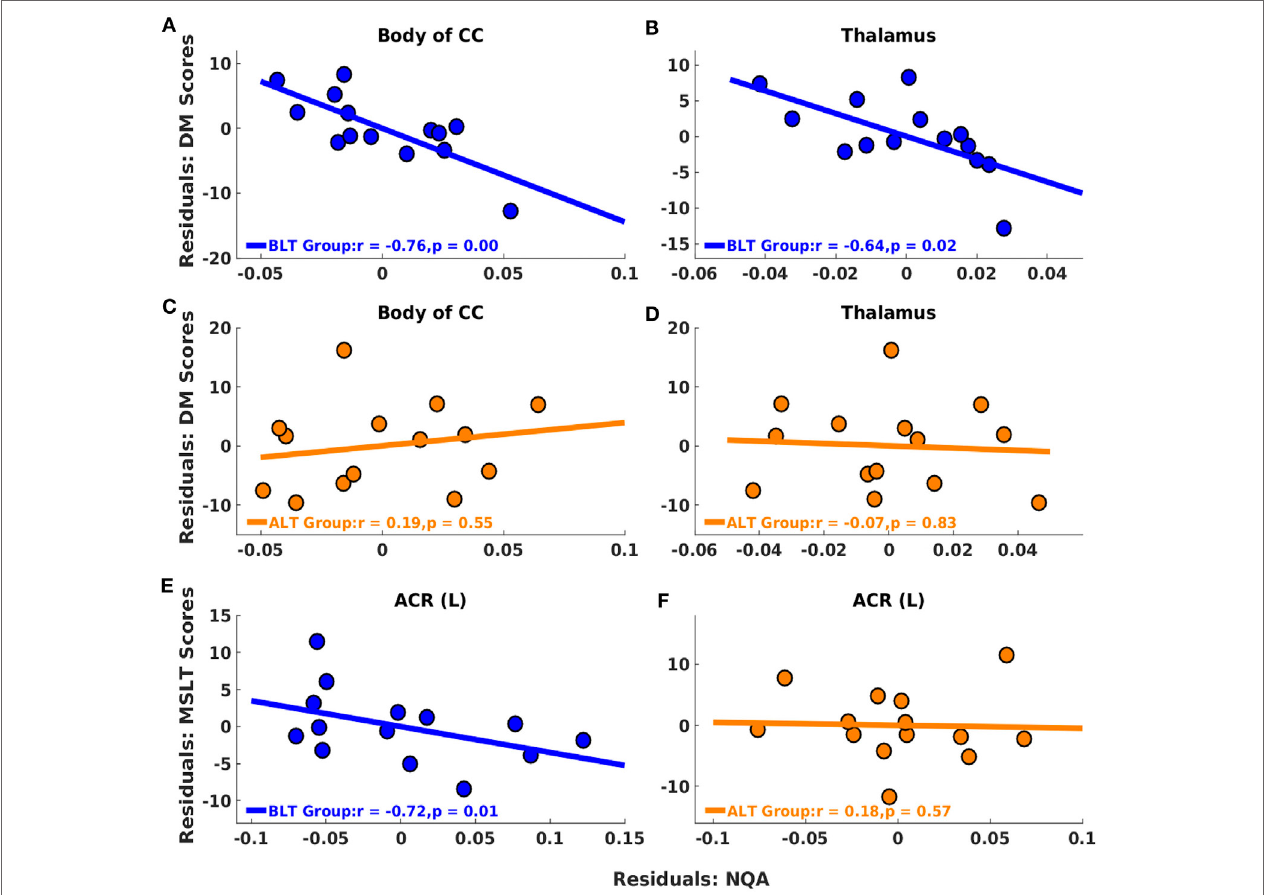
FigUre 4 | Associations between residualized changes in white matter diffusion measures, neuropsychological measures, and multiple sleep latency test (MSLT) scores following BLT and ALT. For BLT and ALT groups, correlations found between residualized changes in NQA and neuropsychological function measures (DM) [BLT: (a,B) , ALT: (c,D) ], and between residualized changes in NQA and MSLT scores [BLT: (e) , ALT: (F) ] are reported. Significant negative correlations between residualized changes in Repeatable Battery for the Assessment of Neuropsychological Status DM scores and NQA measures were found for fibers crossing the body of the corpus callosum (CC) (a) and thalamus (B) for BLT group. No significant correlations were found for ALT group, including for fibers crossing the body of the CC (c) and thalamus (D) . Significant negative correlations between residualized changes in sleep onset latency during the first MSLT administration and NQA measures were also found for fibers crossing the left anterior corona radiata (ACR) (e) for BLT group but not for ALT group (F) . BLT, blue-light therapy; ALT, amber-light therapy, DM, delayed